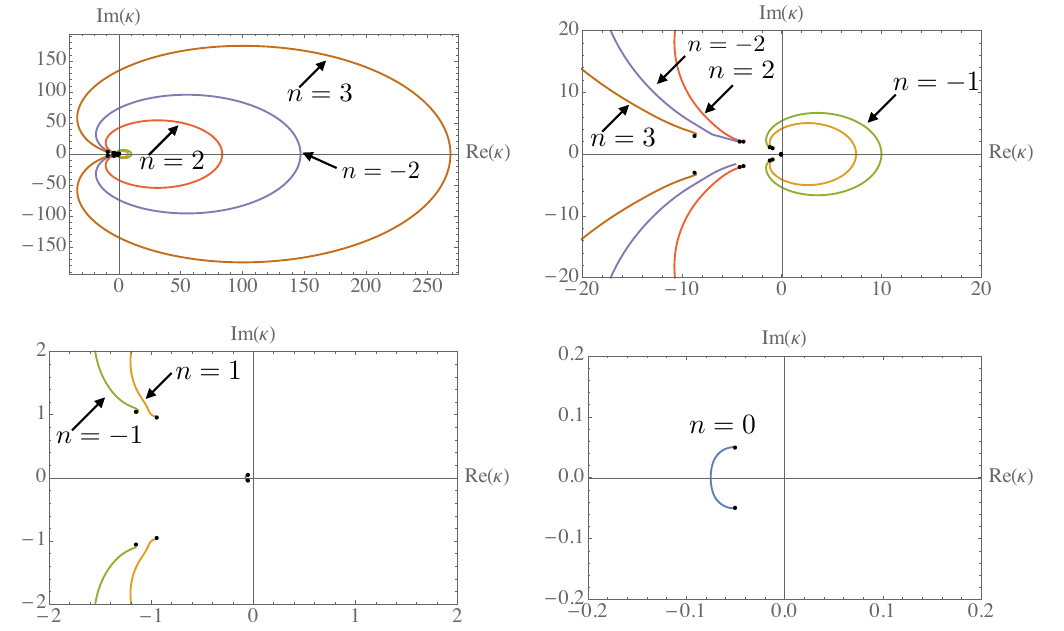
Figure 12 . Plots of solutions for (cid:20) as we interpolate between early and late time behaviors in the decaying (2.43) class. Recall that Im( (cid:20) ) (the vertical axes) determines the exponential decay or growth rate of the Virasoro blocks. The upper left plot shows the full region covering all solutions, and the remaining three plots show scaled up regions of the (cid:12)rst plot for better visibility. Parameters are chosen to be (cid:11) H = i; (cid:11) L = 0 : 99 ; 1 z = 0 : 01. Dots indicate the analytic solutions j (cid:0) j 1 (cid:11) L (cid:11) H (cid:20) = n (1 n ) +( 1 n )( (cid:11) L (cid:11) H ) for n = 2 ; 1 ; : : : 3; each path interpolates between two 2 2 (cid:0) 2 (cid:0) (cid:0) (cid:6) (cid:7) (cid:0) (cid:0) points with the same n and opposite choice of sign for (cid:11) H . All of these saddles decay (cid:6)